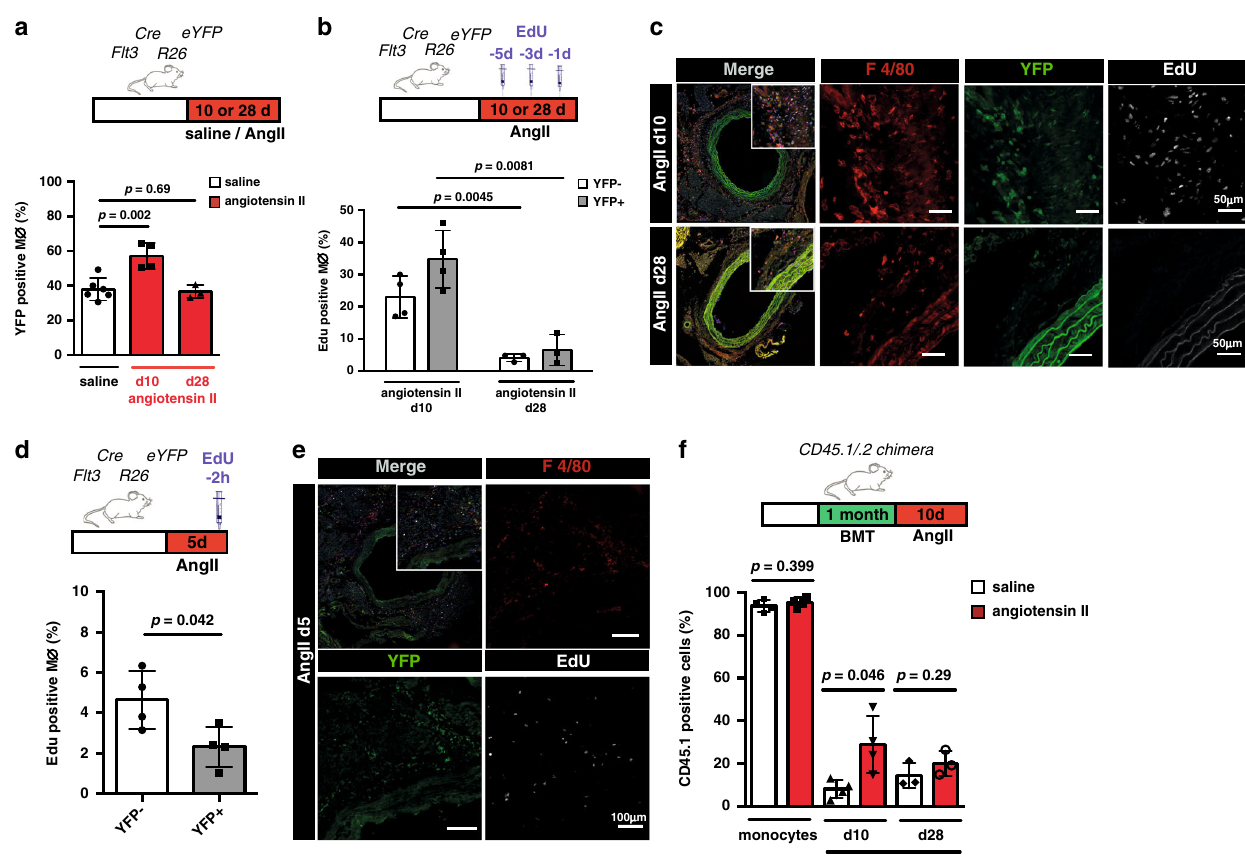
Fig. 5 Local proliferation of resident macrophages and recruitment of BM-derived macrophages in response to AngII. a Schematic of AngII delivery by osmotic pumps implanted into Flt3 Cre Rosa26 eYFP mice for either 10 or 28 days. Percentage of eYFP + macrophages in the adventitia ( n = 6 for steady state; n = 4 for 10d of AngII, n = 3 for 28d of AngII; three individual experiments for steady state and 10 days, and 1 individual experiment for 28 days of AngII). b, d schematic graphs analysing the proliferative behavior of macrophages in response to AngII by repeated injection of EdU i.p. 1, 3 and 5 days ( b ; n = 4 for 10d of AngII, n = 3 for 28d of AngII; each 2 independent experiment) or only once 2h ( d ; n = 4 for 5d of AngII; 1 individual experiment) before euthanization. Quanti fi cation of proliferating eYFP − and eYFP + macrophages in respective groups is shown. c, e representative immunohistology of proliferating arterial macrophages in response to AngII. f AngII or saline pumps were implanted into poly(I:C) treated BM chimeric CD45.2 Mx1 Cre Myb fl ox/ fl ox recipient mice transplanted with CD45.1 BM. Bar-graph shows percentage of CD45.1 monocytes in the blood after 10 days of AngII treatment and CD45.1 macrophages in the adventitia after 10 days ( n = 4 for each group; 2 individual experiments) and after 28 days ( n = 3 for each group; each two independent experiments). Scale bar as depicted in images. Two-sided t -tests was performed. Mean±SD is